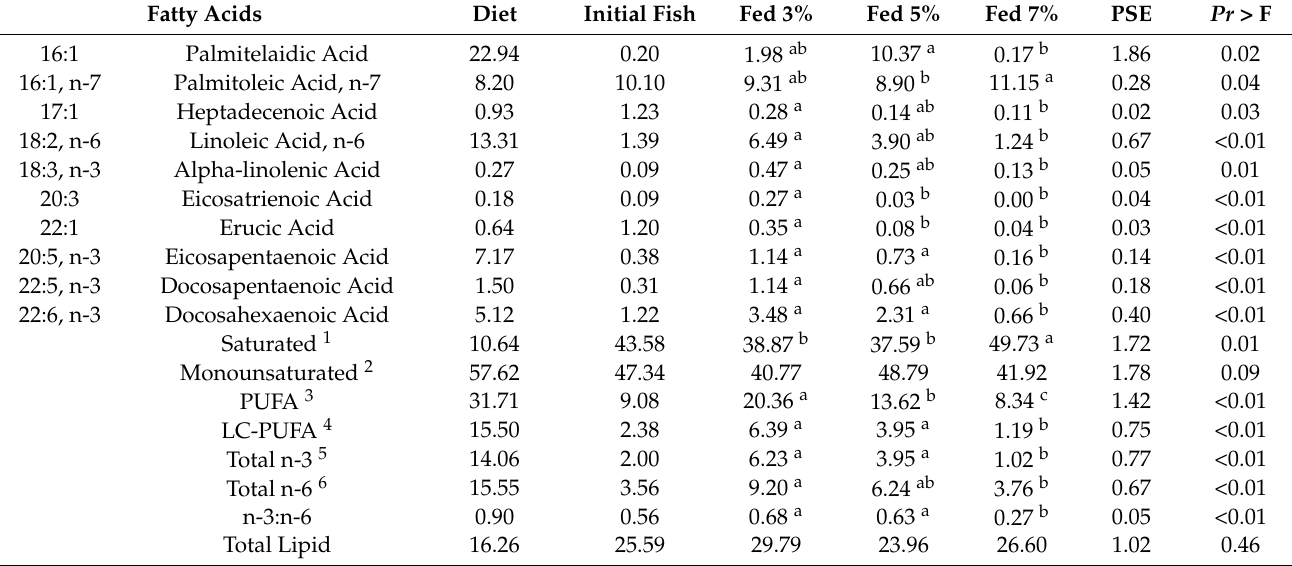
Table 2. Selected fatty acid composition of the diet and whole-body samples (% of total fatty acids by weight) from northern Largemouth bass fingerlings (Trial